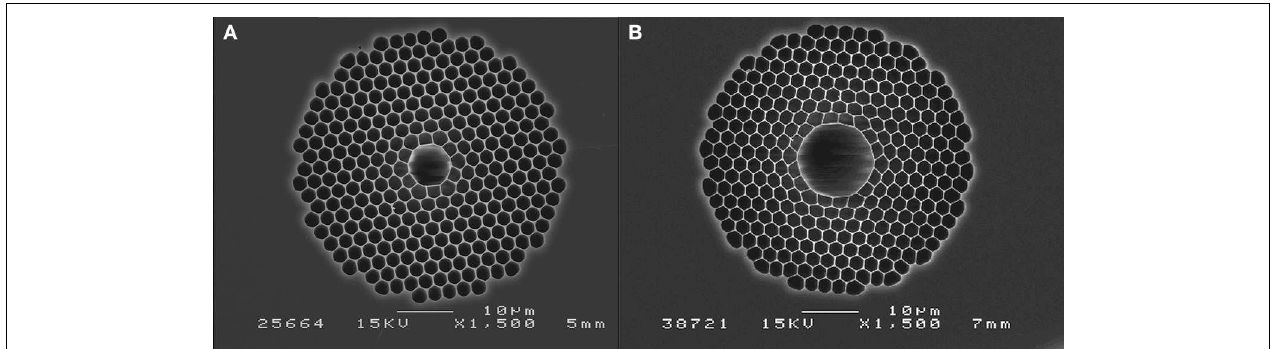
FIGURE 2 | HC-PBGF designed for guidance at 1064nm with (A) an 8 µ m core formed with a seven cell defect and [22] (B) a 13 µ m core formed with a 19 cell defect [23].